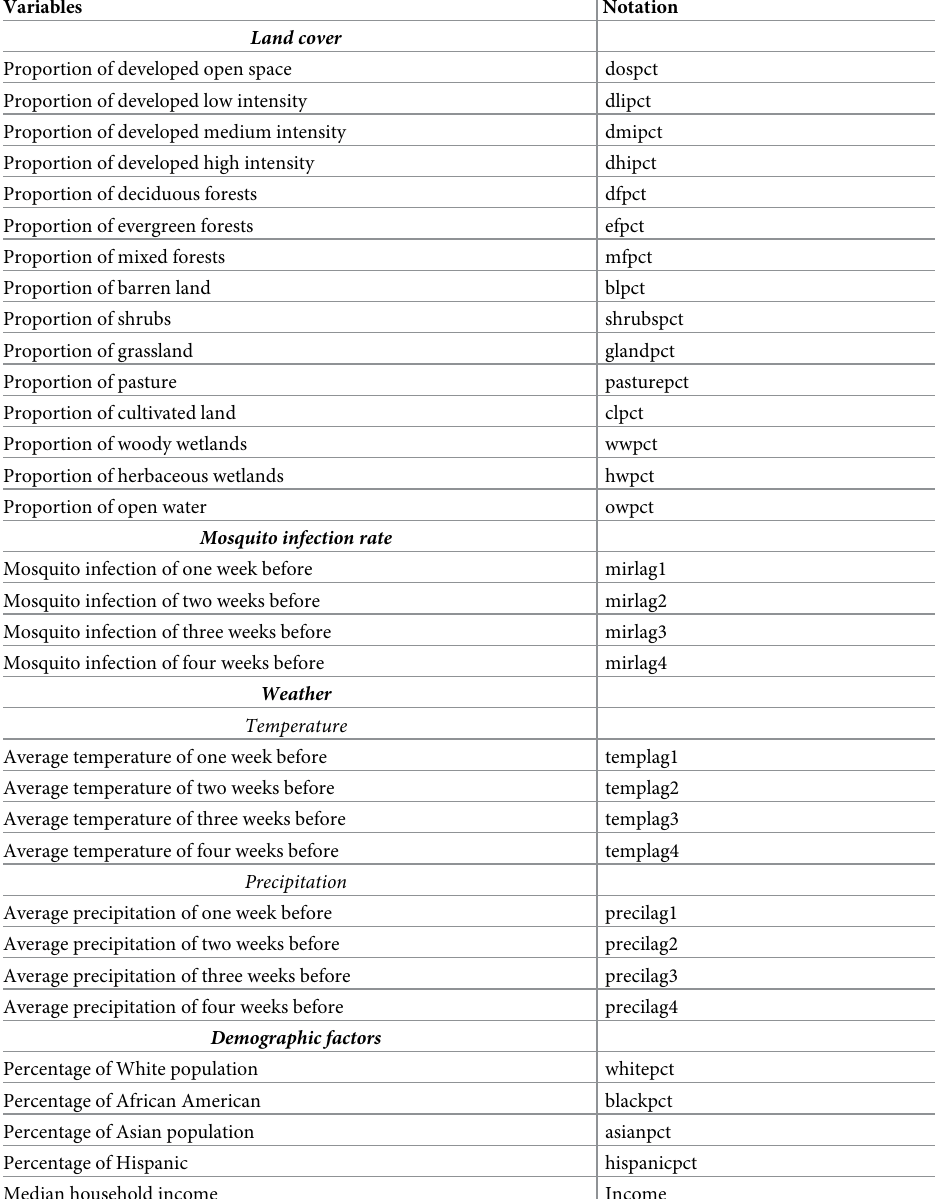
Table 1. List of explanatory variables. Variables Notation Land cover Proportion of developed open space dospct Proportion of developed low intensity dlipct Proportion of developed medium intensity dmipct Proportion of developed high intensity Proportion of deciduous forests Proportion of evergreen forests Proportion of mixed